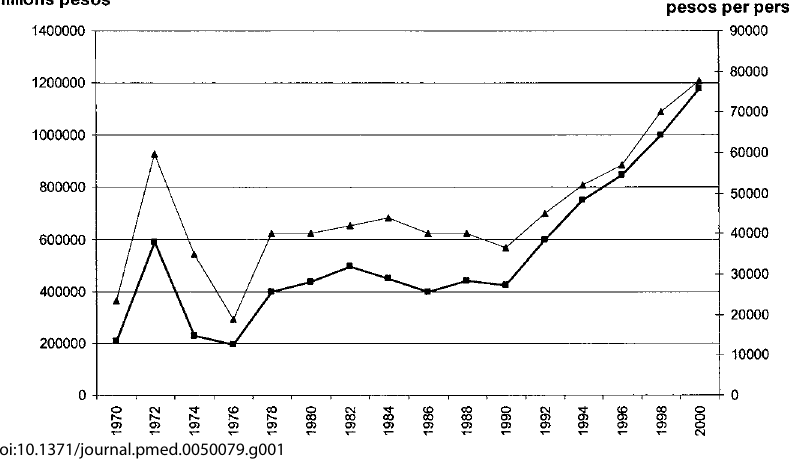
Figure 1. Public Expenditure on Health in Chile, 1970–2000 (Pesos 2000) As the graph shows, there was a sharp increase in public health expenditure (in 2000 Chilean pesos) in Chile after 1990, with social democratic governments. A short spike can be observed during the socialist Allende government. The lower darker line represents public expenditure, the upper lighter one public expenditure per person. From [13].